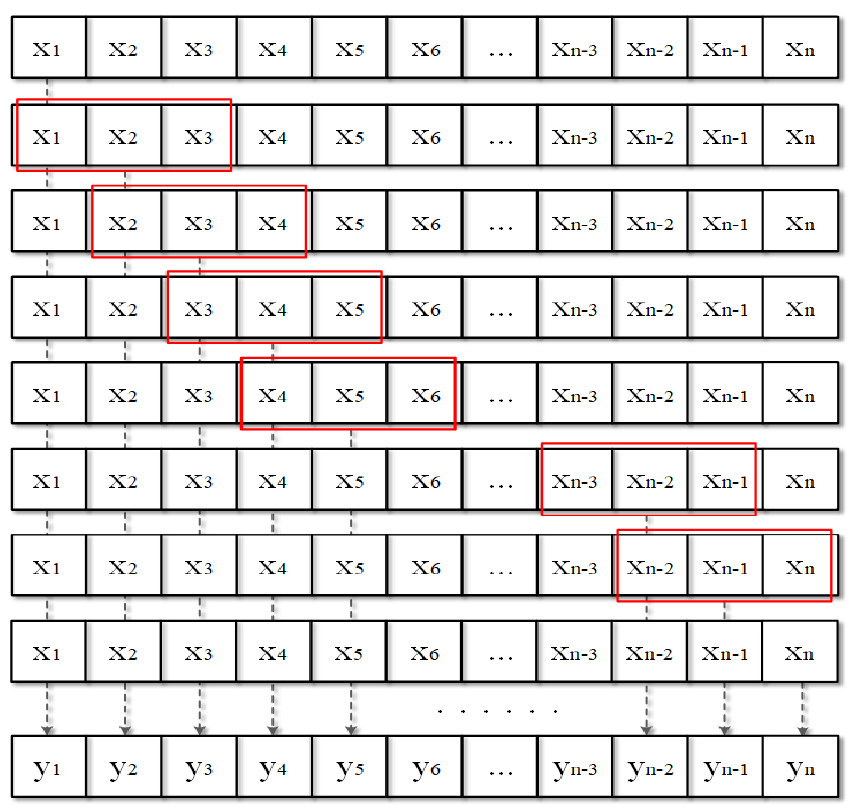
Figure 2. Sliding window denoising diagram.